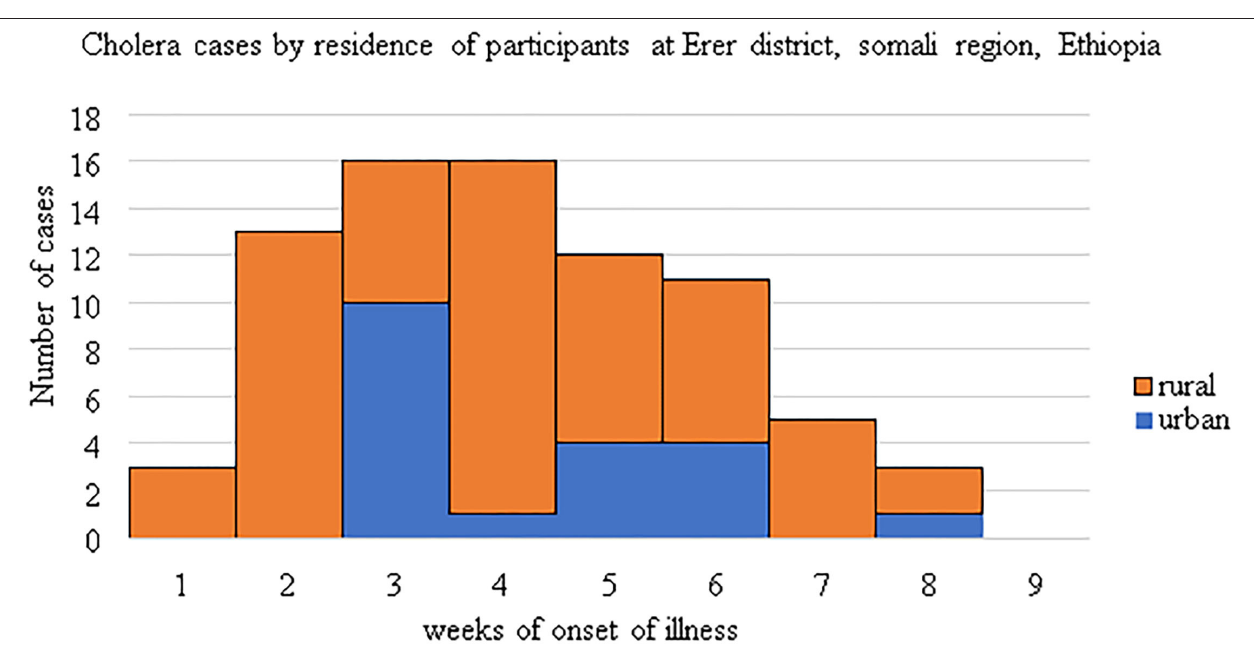
FIGURE 2 | An epidemic curve showing the difference in the distribution of cases by residence and onset weeks of cholera